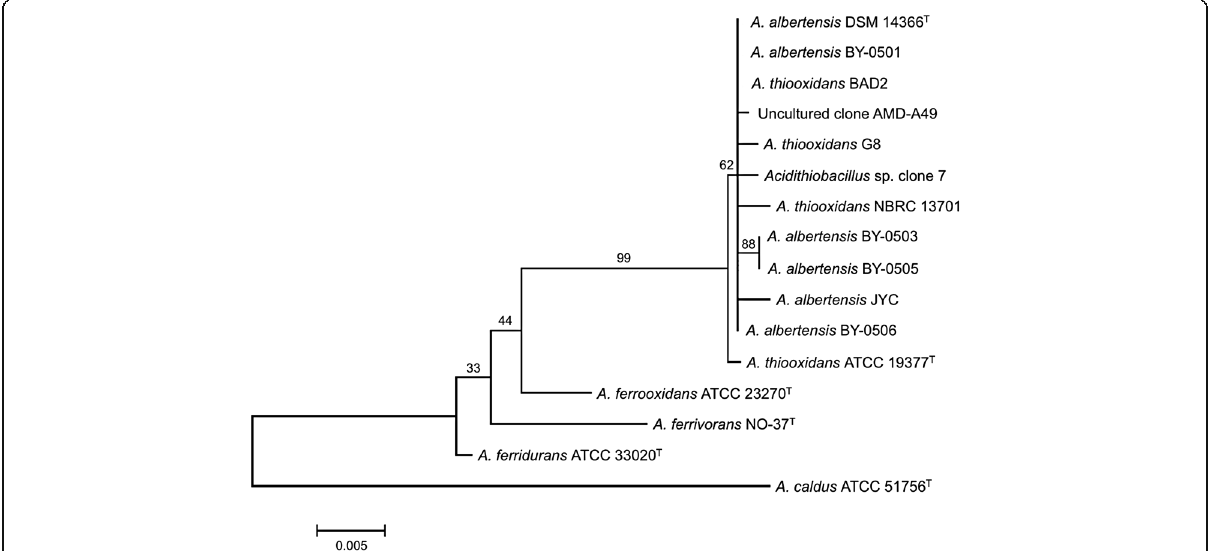
Fig. 1 Phylogenetic tree based on 16S rDNA sequence information position of A. albertensis strain DSM 14366 T (type strain = T ) relative to other type and non-type strains within the acidithiobacilli. The strains and their corresponding GenBank accession numbers for 16S rRNA genes are: A. albertensis DSM 14366 T , NR_028982; A. albertensis BY0501, FJ032185; A. albertensis BY0503, FJ032186; A. albertensis BY0505, FJ032187; A. albertensis BY0506, GQ254658; A. albertensis JYC, FJ172635; A. thiooxidans ATCC 19377 T , Y11596; A. thiooxidans BAD2, KC902821; A. thiooxidans G8, KC902819; A. thiooxidans NBRC13701, AY830902, AMD uncultured clone c7, JX989232; A. ferrooxidans ATCC 23270 T , NR_074193; A. ferrivorans NO-37, NR_114620; A. ferridurans ATCC 33020 T , NR_117036; A. caldus ATCC 51756 T , CP005986. The tree was inferred using the Neighbor-Joining method [51]. The optimal tree with the sum of branch length=0.08720008 is shown. The percentage of replicate trees in which the associated taxa clustered together in the bootstrap test (1000 replicates) are shown next to the branches. The tree is drawn to scale, with branch lengths in the same units as those of the evolutionary distances used to infer the phylogenetic tree. The evolutionary distances were computed using the Maximum Composite Likelihood method [52] and are in the units of the number of base substitutions per site. The analysis involved 34nucleotide sequences. There were a total of 1314 positions in the final dataset. Evolutionary analyses were conducted in MEGA6